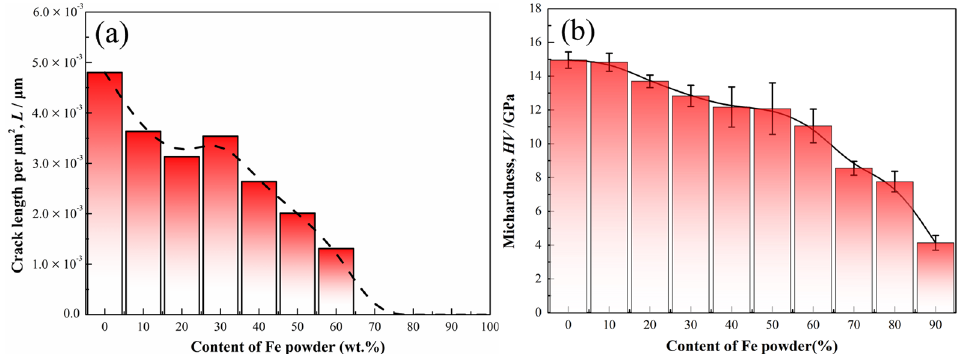
Figure 9. ( a ) Length statistics of cracks in cross section and ( b ) Vickers hardness of Co-based composite coatings prepared by laser cladding with the different mass contents of Fe